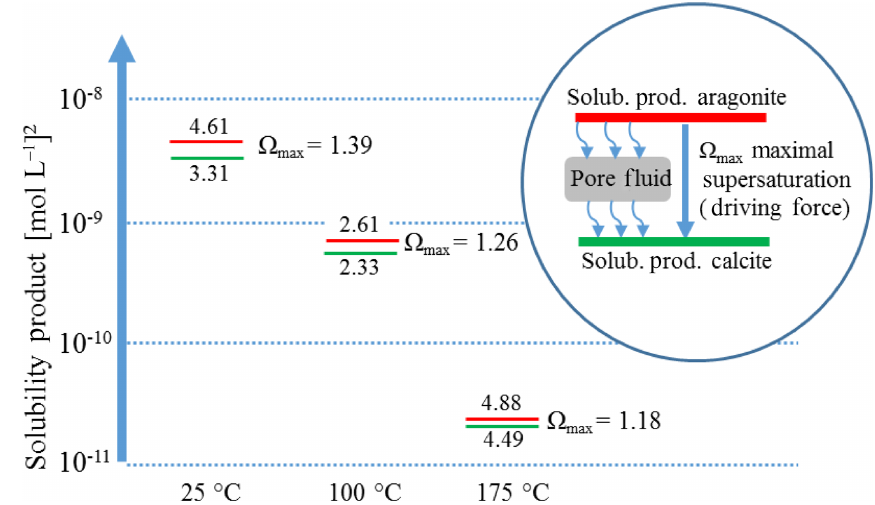
Figure 12. Solubility products of aragonite and calcite calculated from the data of Plummer and Busenberg (1982). The labels at the ordinate give the powers of 10, and the numbers in the plot give the mantissa of the SP. (cid:127) max is the difference between the value for aragonite (red) and calcite (green), and it is the upper bound of the supersaturation available to drive calcite precipitation from aragonite dissolution (thermodynamic driving force (cid:49) max = RT ln (cid:127) max ) . To drive dissolution of aragonite and precipitation of calcite at non-zero rates, the pore fluid needs to be undersaturated with respect to aragonite and supersaturated with respect to calcite.